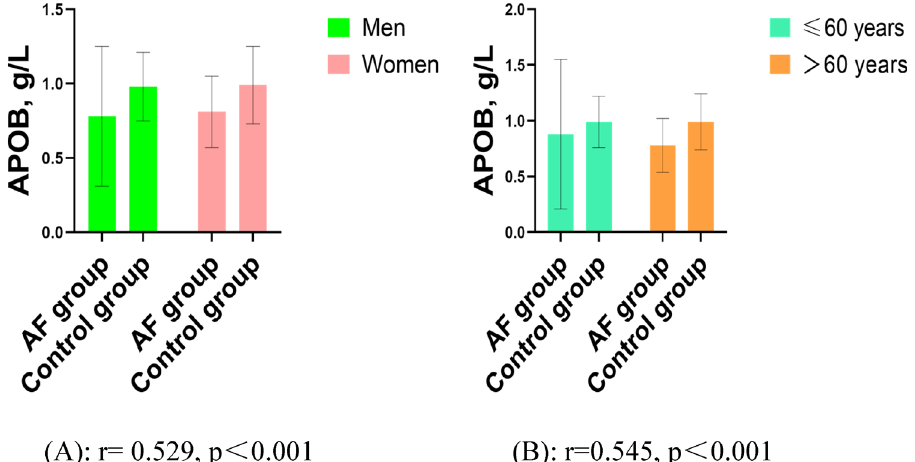
Figure 1. APOB levels in the AF group and control group by age and gender. Compared with controls, APOB levels of the AF group were significantly lower in the men (0.78 ± 0.47 vs. 0.98 ± 0.23 g/L, P < 0.001) and women (0.81 ± 0.24 vs. 0.99 ± 0.26 g/L, P < 0.001). Compared with controls, APOB levels of the AF group were significantly lower in the patients with age ≤ 60 years (0.88 ± 0.67 vs. 0.99 ± 0.23 g/L, P < 0.001) and age > 60 years (0.78 ± 0.24 vs. 0.99 ± 0.25 g/L, P < 0.001). Abbreviations as in Table 1. The figures were developed by GraphPad Prism software (version